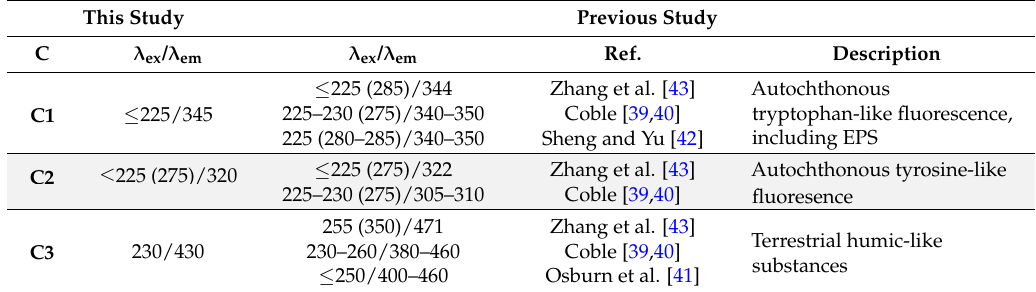
Figure 4. Typical excitation-emission matrices for the river water samples. The respective abbreviations of Em and Ex represent the excitation and emission wavelengths of the FEEM-PARAFAC analysis. Table 1. Characteristics of the fluorescence excitation-emission matrices (FEEM) peaks in this study and commonly-observed FEEM peaks from previous studies. Values in brackets represent secondary